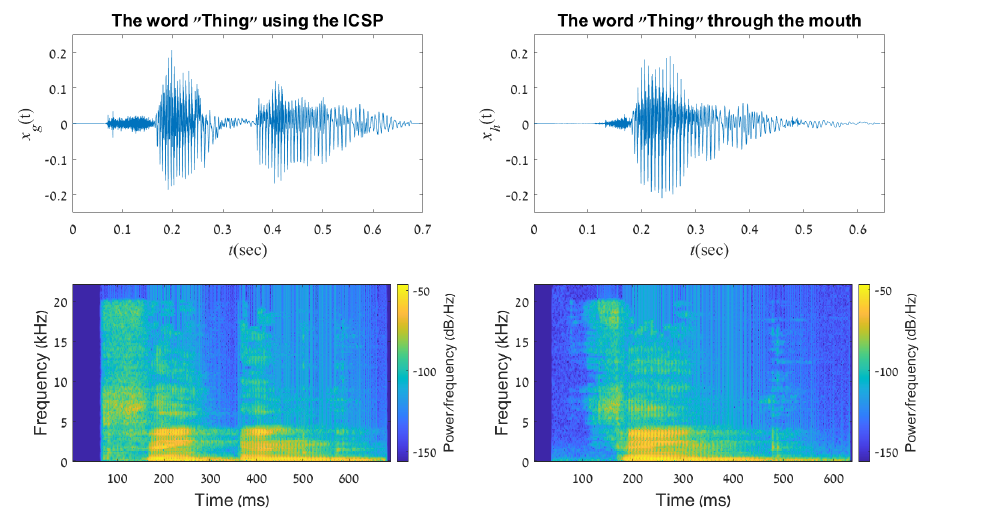
Figure 8. A representation of the word “Thing” in time domain and frequency spectrogram, created using the ICSP ( left column ) and the human mouth ( right column